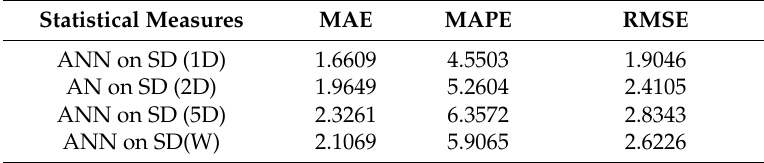
Table 2 present the statistical summary of the results of FFBPNN for one day (1D), two days (2D), five days (5D), and one week (W) hourly energy consumption prediction results of ANN on normalized data. The MAE, MAPE, and RMSE values for normalized data are lower when compared to the simple data which illustrate that FFBPNN performs better on normalized data as compared to simple